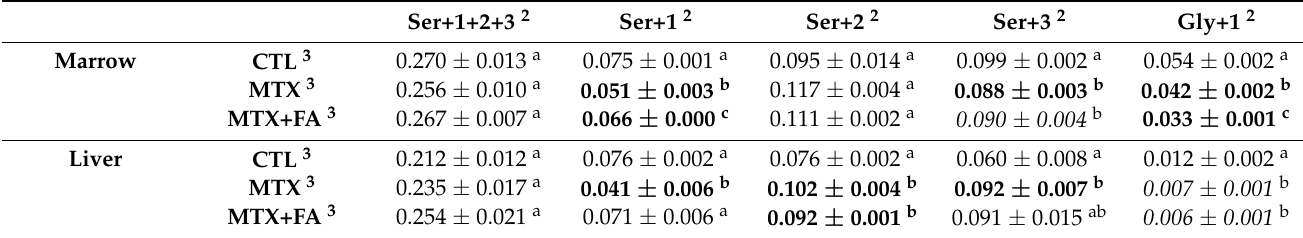
Table 3. MTX and folinate change the utilization of serine in glycine synthesis in mouse bone marrow and liver proteins 1